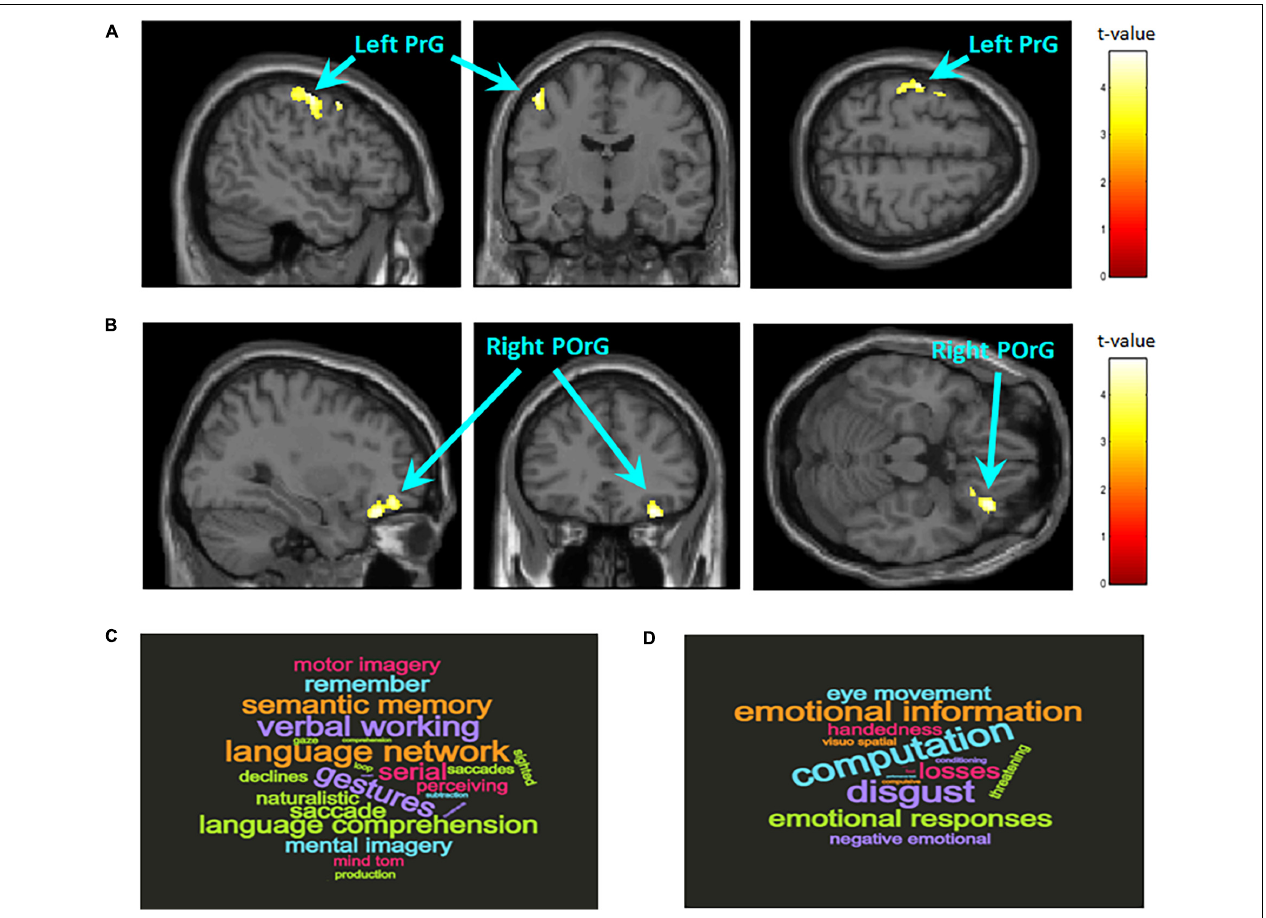
FIGURE 1 | Brain regions with significantly larger gray matter volume in the control group compared to the ADHD group. The statistical threshold for the contrasts was set at voxel-level P < 0.001 uncorrected for height and cluster-level P < 0.05 family wise error rate corrected for multiple comparisons. The color bar denotes the t -statistic range. (A) Left precentral gyrus (PrG; BA6; MNI coordinates, x = –44, y = 5, z = 57; cluster size = 437 voxels). (B) Right posterior orbital gyrus (POrG; BA47; MNI coordinates, x = 24, y = 21, z = –21; cluster size = 555 voxels). Reverse inference of functional properties in the left PrG (C) and right POrG (D) as decoded by NeuroSynth. The font size represents the rank according to the strength of the relationship between regions and